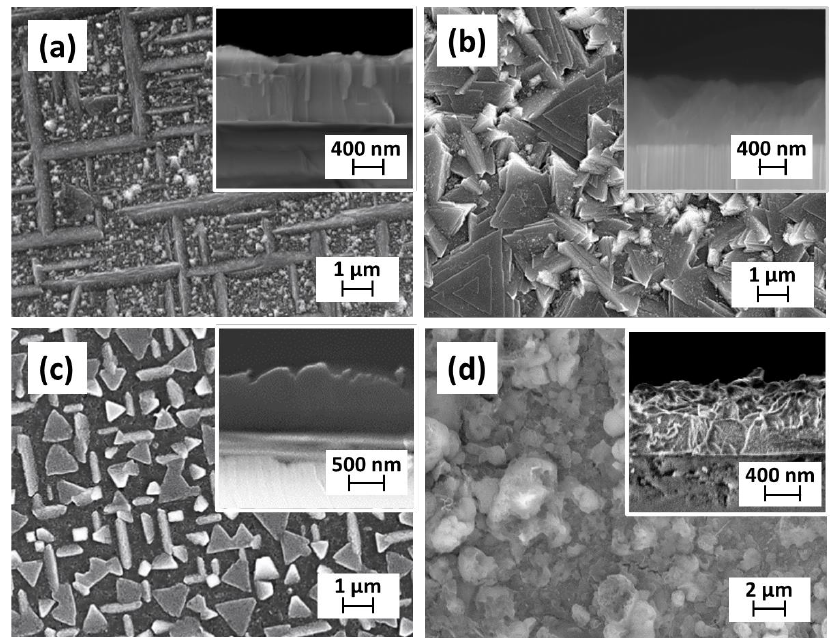
Figure 3. FE-SEM images of Ba – Ce-based thin films grown on the MgO (100) substrate at different deposition temperatures: ( a ) 800 °C; ( b ) 850 °C; ( c ) 900 °C; and ( d ) 950 °C. Insets in the FE-SEM images report the cross-section of the corresponding films.